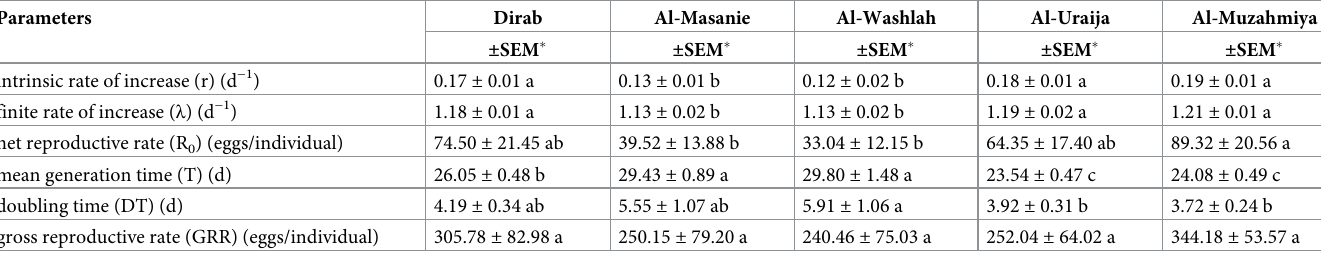
The parameter s refers to the possible survival of newly born eggs to age x and development xj to stage j (Fig 1). In all the populations the peak value of s for larvae was similar. However, xj the highest peak values of s for pupae in the Dirab (0.80) and Al-Washlah (0.70) populations xj Table 3. Demographic life table features of five house fly populations collected from dairies in Riyadh, Saudi Arabia. Parameters Dirab Al-Masanie Al-Washlah